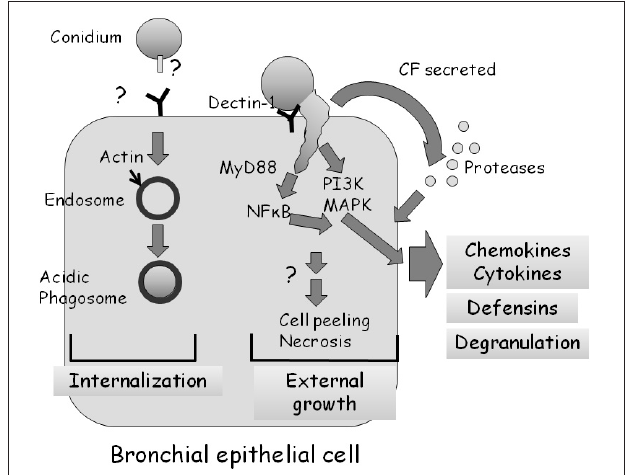
FIGURE 3 | Interaction of A. fumigatus with a bronchial epithelial cell. Approximately 30% of adherent A. fumigatus conidia undergo internalization into endosomeswhich subsequently fuse to form acidic phagosomes. This process is dependent on the polymerization of actin around the endosome. Most ingested cells remain alive in the acidic phagosomes for up to 20h. Approximately 70% of adherent A. fumigatus conidia germinate externally, activating MyD-dependentNFkB, PI3 kinase, and MAP kinase signaling, leading to chemokine and cytokine synthesis in a dectin-1 dependent manner. A. fumigatus infection also stimulates, through as yet unknown signaling pathways, the production of antimicrobial defensins and cell degranulation. Proteases secreted by the fungus also activate the production of